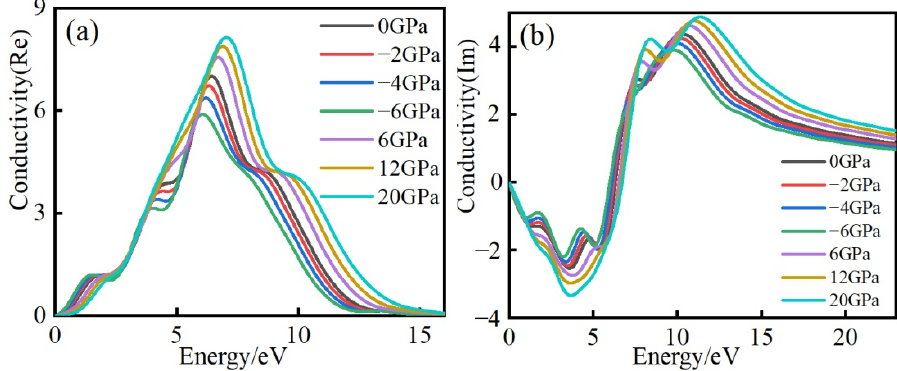
Figure 9. Complex conductivity for ( a ) real part and ( b ) imaginary part.